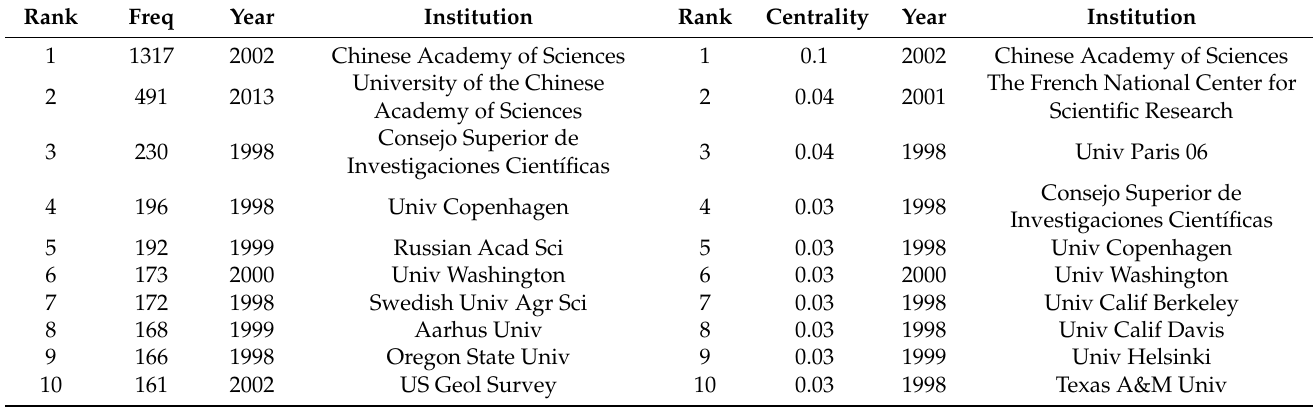
Table 6. Contributing institutions by frequency and